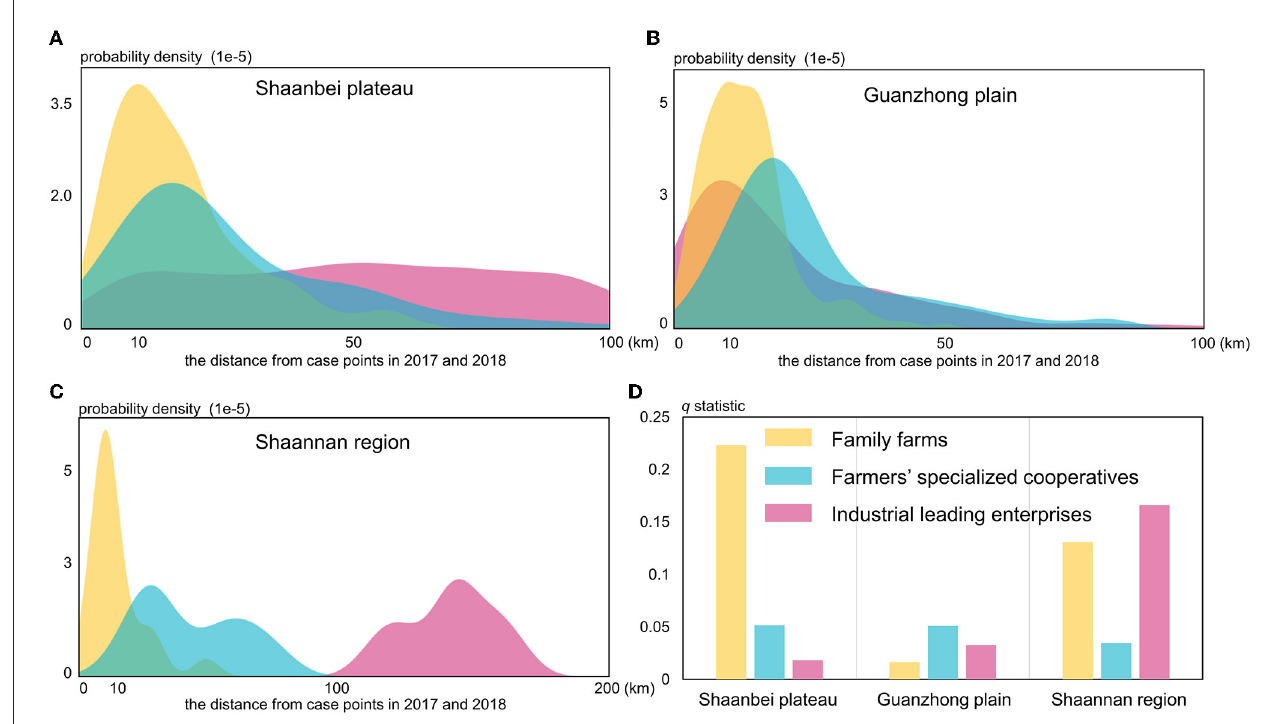
FIGURE8 The probability density distributions in three regions of Shaanxi Province (A–C) and q -statistic values (D) for the livestock agricultural variables.